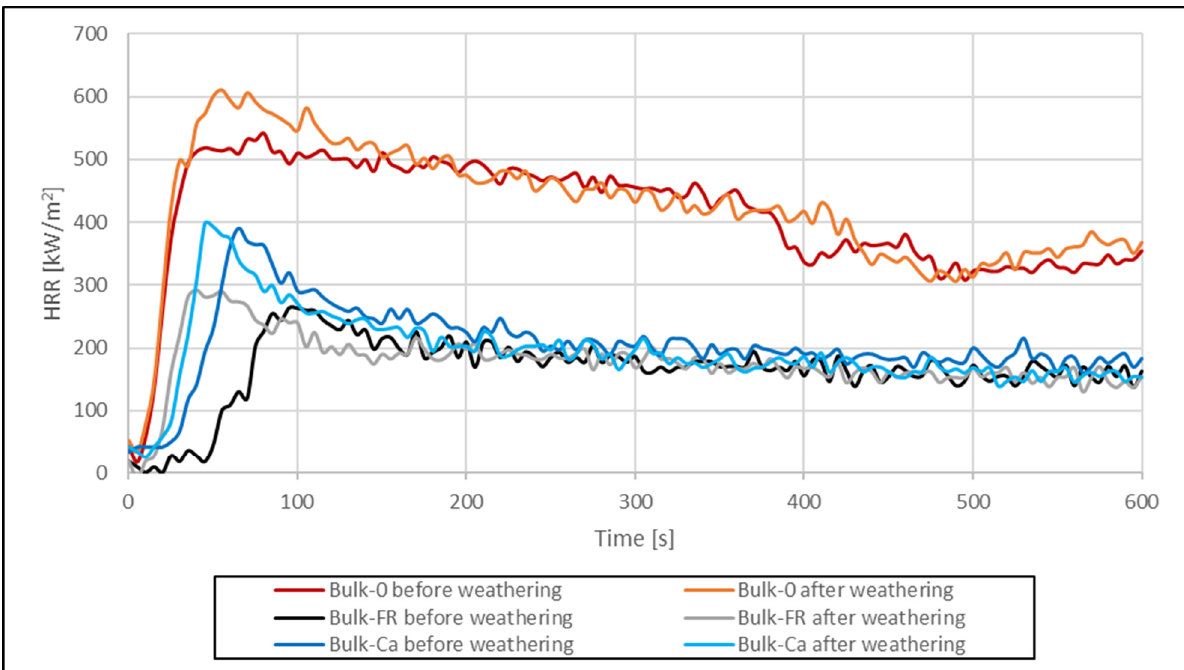
Figure 21. HRR of profiles with addition of FR CROS 490 or calcium carbonate in the bulk, before and after weathering.